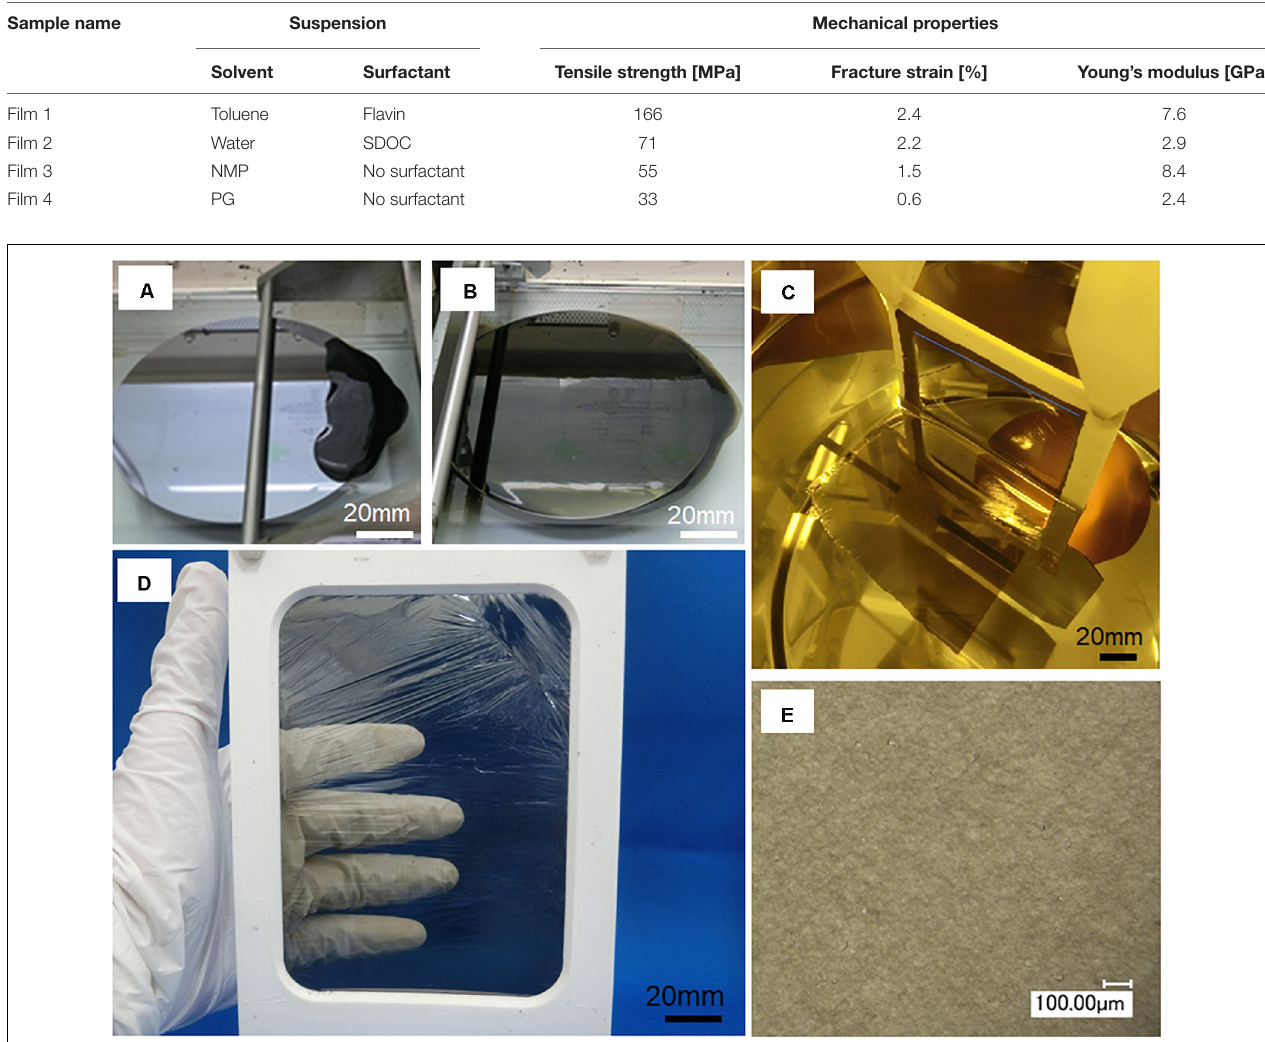
FIGURE 1 | (A,B) Photograph of the CNT suspension blade-coating process, (C) photograph of the CNT film transfer process, and (D,E) photograph and optical micrograph of a free-standing CNT